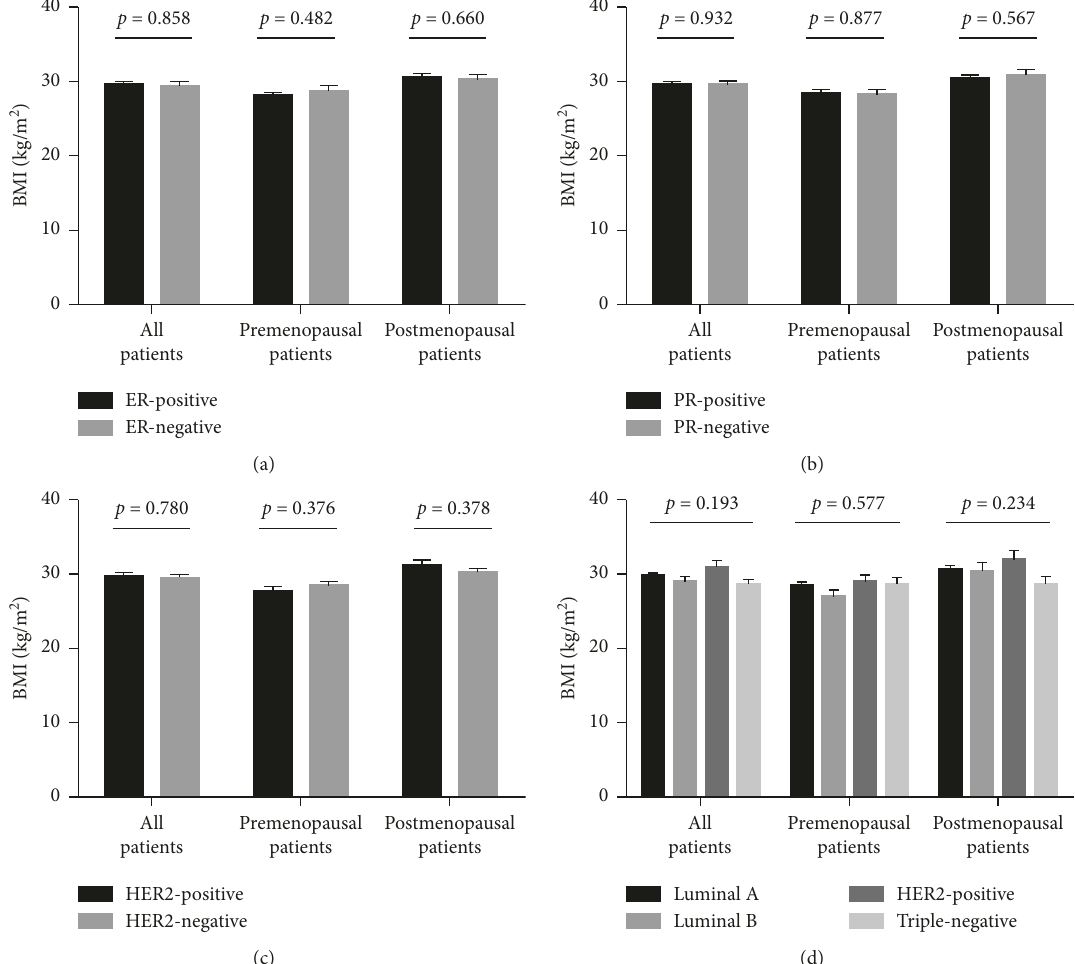
Figure 1: Association of BMI with receptor status and molecular subtype in breast cancer patients at time of diagnosis. BMI among all patients, premenopausal cases, and postmenopausal cases in relation to (a) ER, (b) PR, (c) HER2, and (d) molecular subtype. Bars represent mean BMI SEM. BMI, body mass index; ER, estrogen receptor; HER2, human epidermal growth factor receptor 2; PR, progesterone